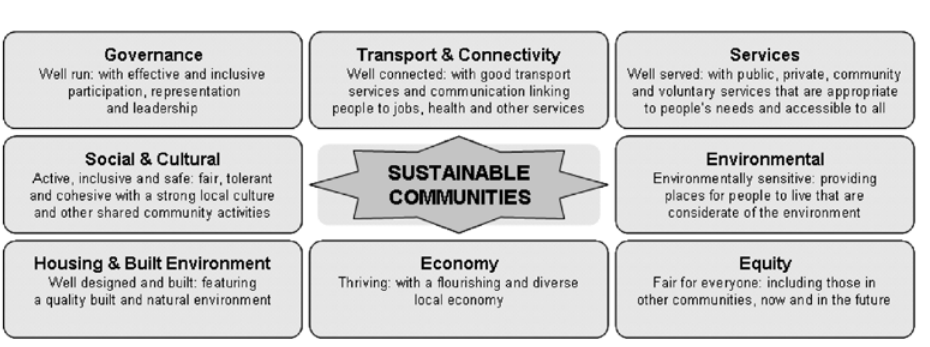
Fig. 2. The 8 components of sustainable communities. Adopted from the Egan review and EU Bristol Accord (Office of the Deputy ... 2003; Roberts and Jeffrey